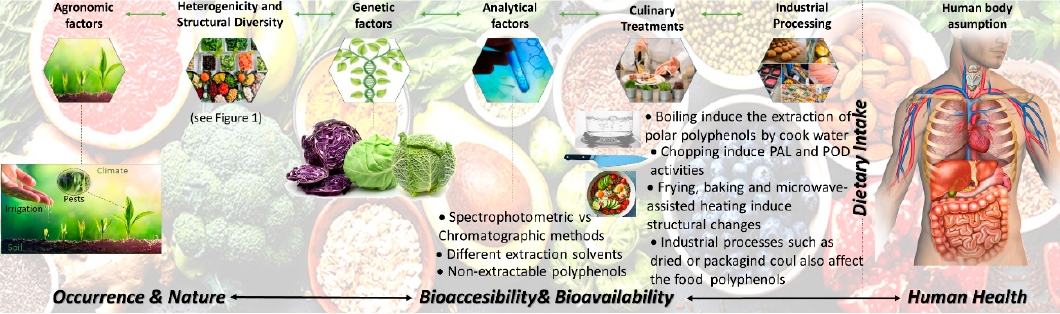
Figure 2. Factors affecting the relationship between dietary intake of polyphenols and healthy Figure 2. Factors a ff ecting the relationship between dietary intake of polyphenols and healthy outcomes.